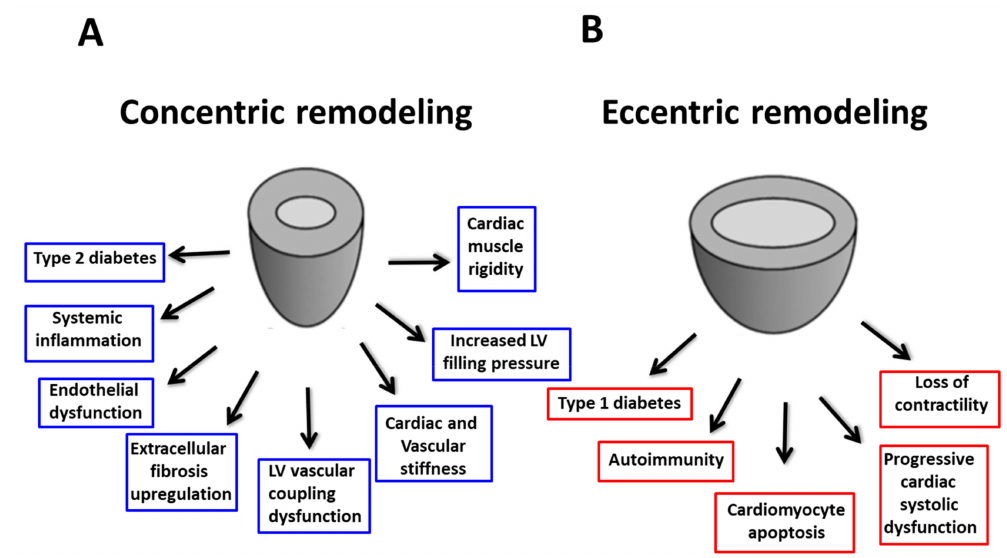
Figure 3. Di ff erent phenotypes in diabetic cardiomyopathy: ( A ) concentric remodeling due to increased fibrosis, cardiovascular sti ff ness and LV chamber rigidity. ( B ) eccentric remodeling due to cell apoptosis, progressive cardiac enlargement and systolic impairment. LV: left